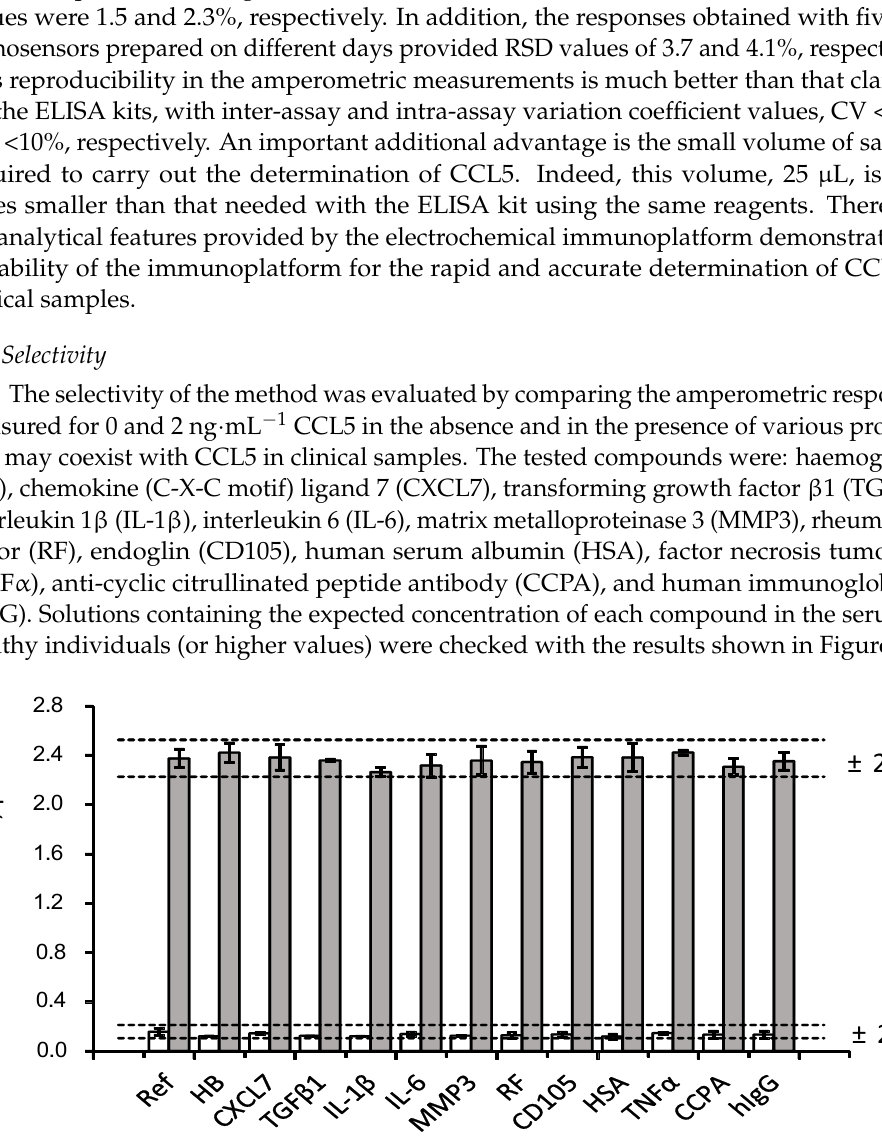
Figure 5. Effect of the presence of 5 mg mL − 1 HB, 50 ng · mL − 1 CXCL7, 50 pg · mL − 1 TGF β 1, 50 pg · mL − 1 IL-1 β , 300 pg · mL − 1 IL-6, 2 ng mL − 1 MMP3, 100 IU · mL − 1 RF, 70 pg mL − 1 CD105, 5 mg · mL − 1 HSA, 200 pg mL − 1 TNF α , 100 IU · mL − 1 CCPA and 1 mg · mL − 1 hIgG, on the amperometric responses obtained with the developed immunosensor for 0 (white) and 2 ng mL − 1 CCL5 (grey). Error bars are estimated as triple the standard deviation ( n =